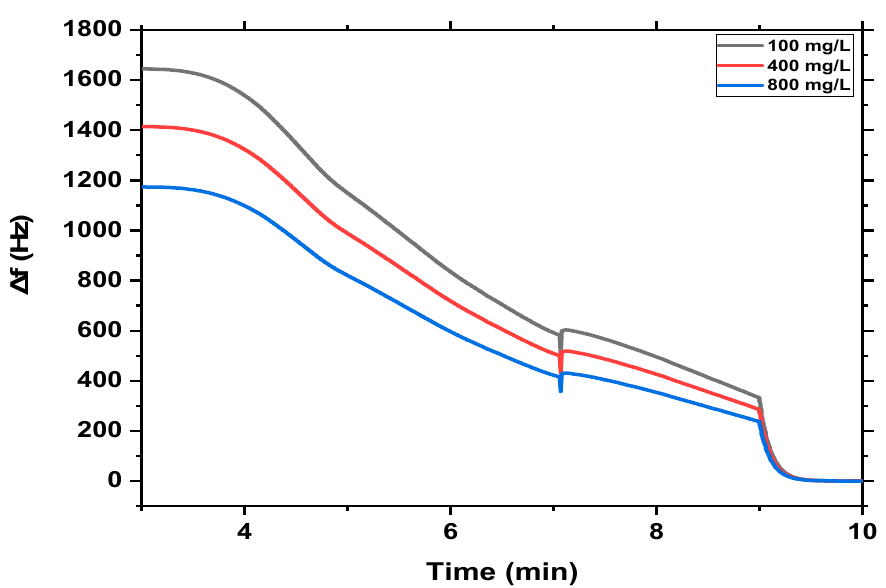
Figure 7. Illustrates the real-time detection of different concentrations of MB dye (100 mg/L, 400 mg/L, and 800 mg/L) on the surface of the MgFe 2 O 4 @CaAlg NCs nanosensor at room temperature.